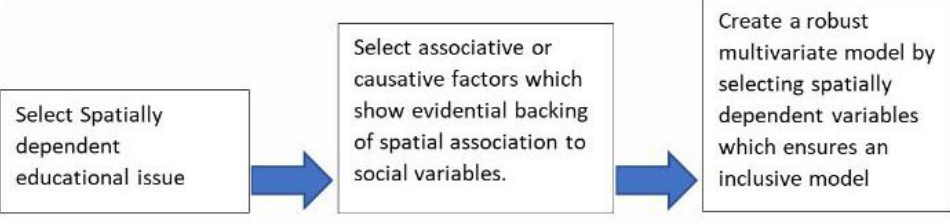
Figure 2. Geospatial Workflow